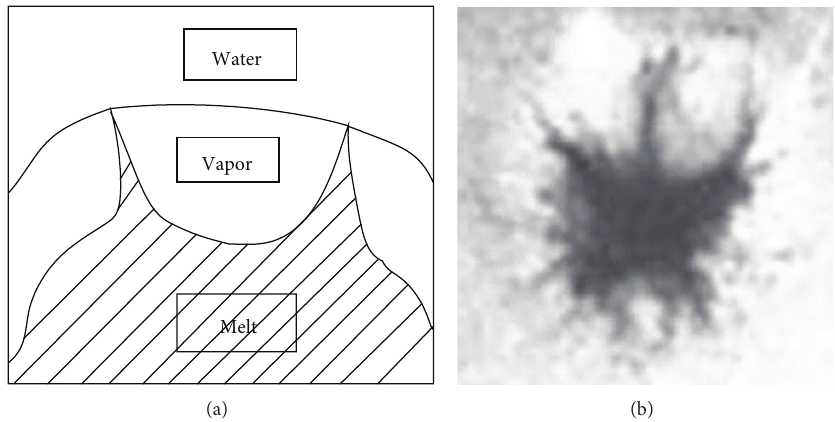
Figure 7: Description of Ciccarelli and Frost’s model [2] (a) and the experimental observation (b).